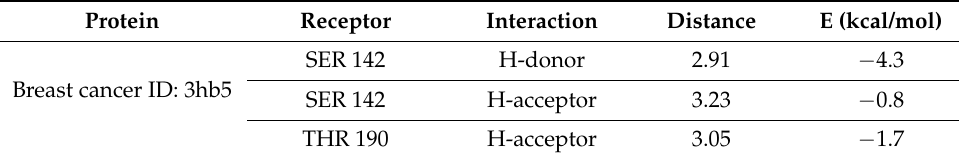
Table 9. Binding energy of the interaction with Pd complex.